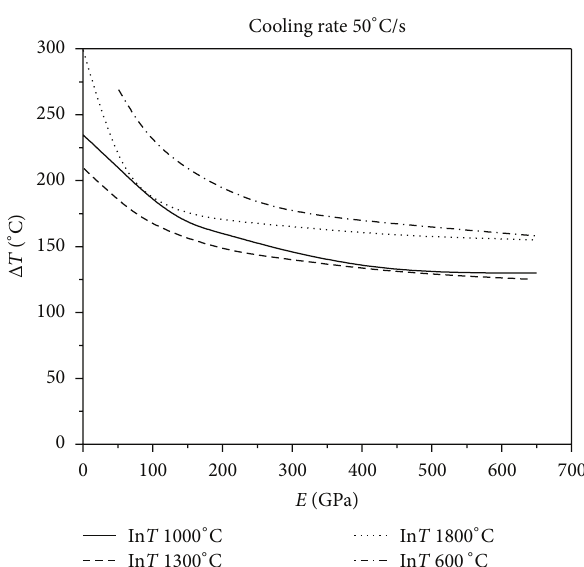
Figure8:Relationshipbetweencriticalfracturetemperaturescorre- sponding to different thermal shock initial temperature and Young’s modulus of constraint material under the cooling rate 400 ∘ C/s.